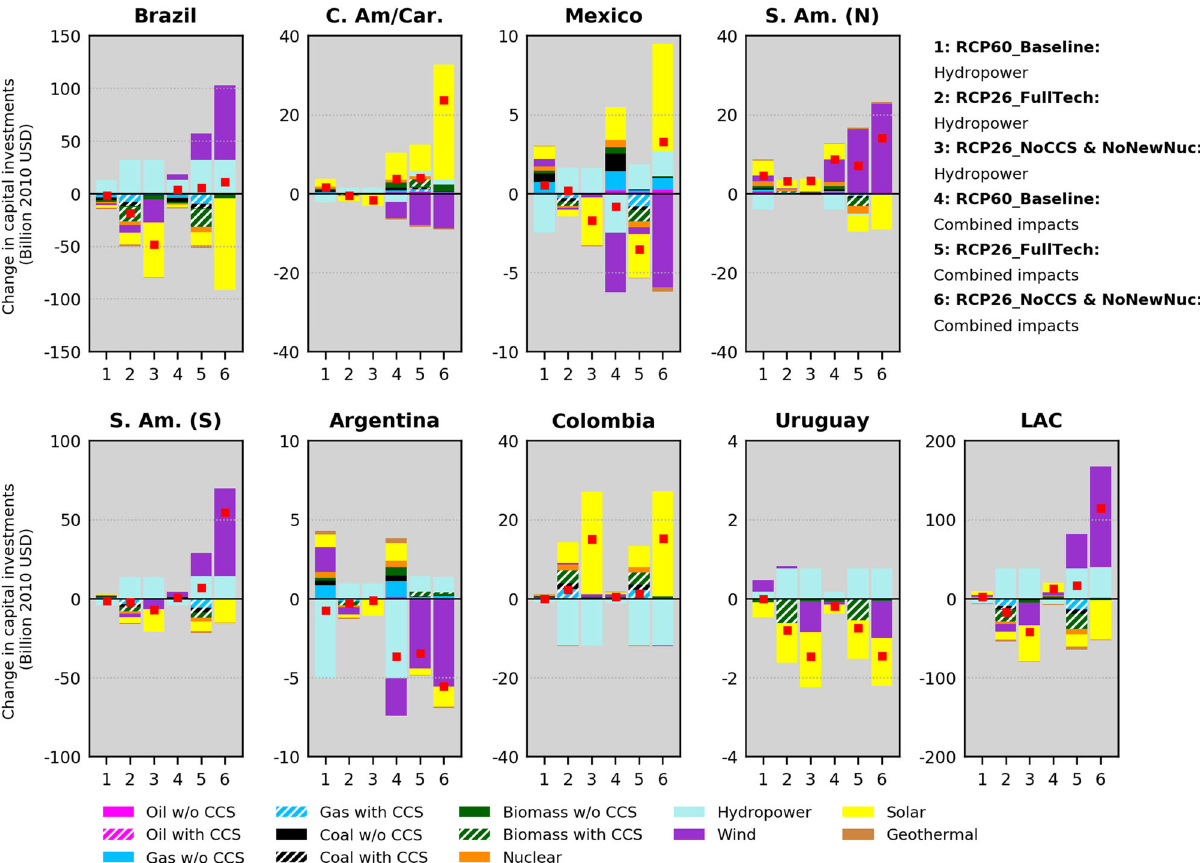
Fig. 3 Model mean differences in capital investments by technology in LAC assuming climate change impacts on renewables. Differences are calculated by technology using cumulative investments (USD) in the 2020 ─ 2100 period. Differences are relative to the No-Climate impacts scenarios (i.e., positive values mean that scenarios with climate impacts show increased costs). The red squares indicate the net of the positive and negative changes for a given scenario (and are equal to the total investment changes plotted in Fig. 2). Note the different y axis scales. Results for the period 2020 ─ 2050 are provided in Supplementary Fig.